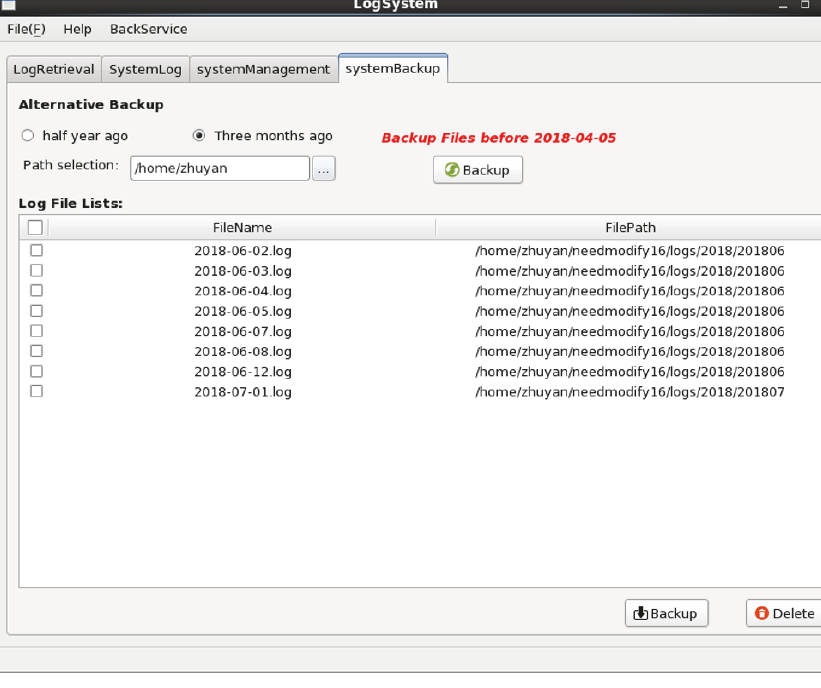
Figure 4: Log retrieval interface.